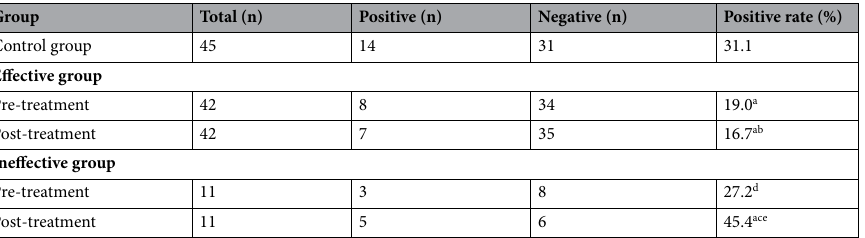
Table 5. Effect of glucocorticoid on P-gp expression in UC. a P < 0.05 versus control group. b P > 0.05 versus pre-treatment. c P < 0.05 versus pre-treatment. d P < 0.05 versus effective group before treatment. e P < 0.05 versus effective group